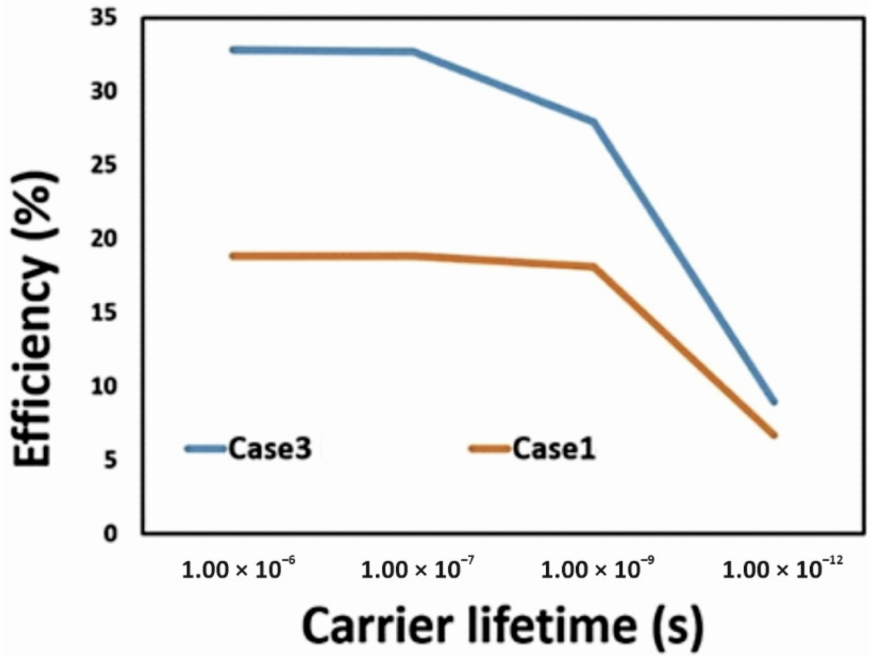
Figure 4. Efficiency variation versus carrier